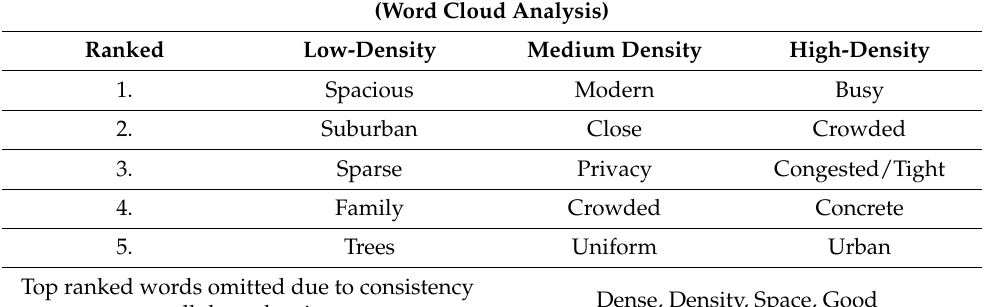
Table 3. Word Cloud Analysis.